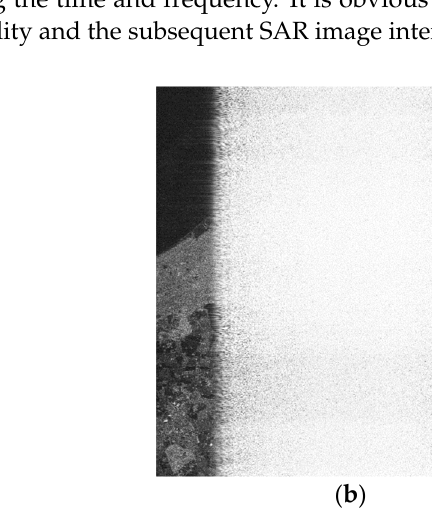
Figure 12. SAR image of the measured data ( a ) without RFI and ( b ) corrupted with simulated RFI.